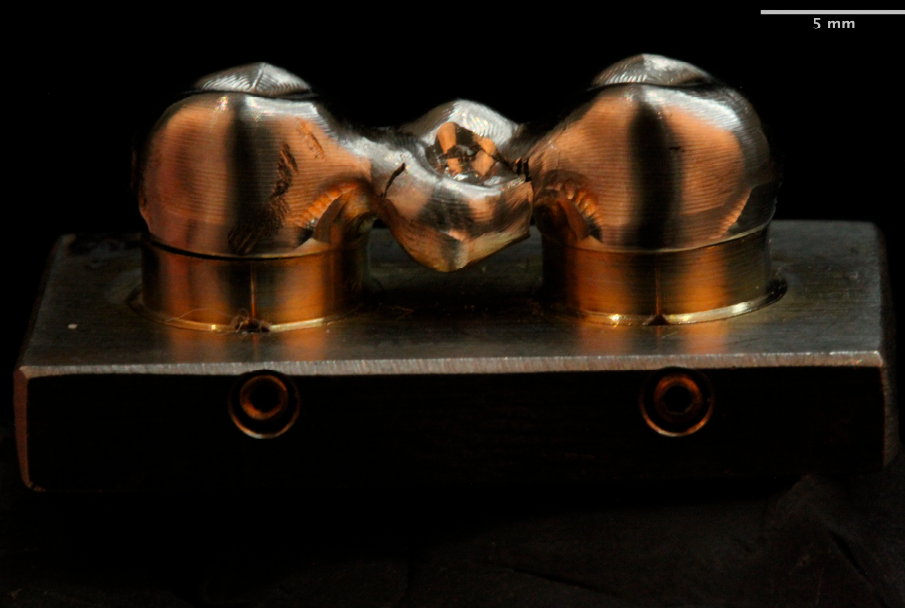
Figure 4. Zirconia framework fracture.